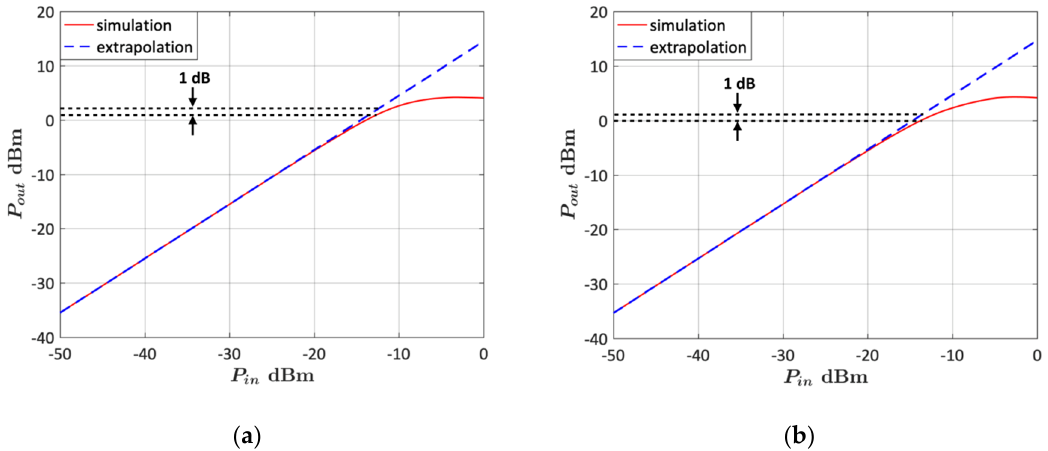
Figure 13. Non-linear simulation of the LNA output power vs. input power. ( a ) Lower-frequency state (120 GHz); ( b ) upper-frequency state (140 GHz).